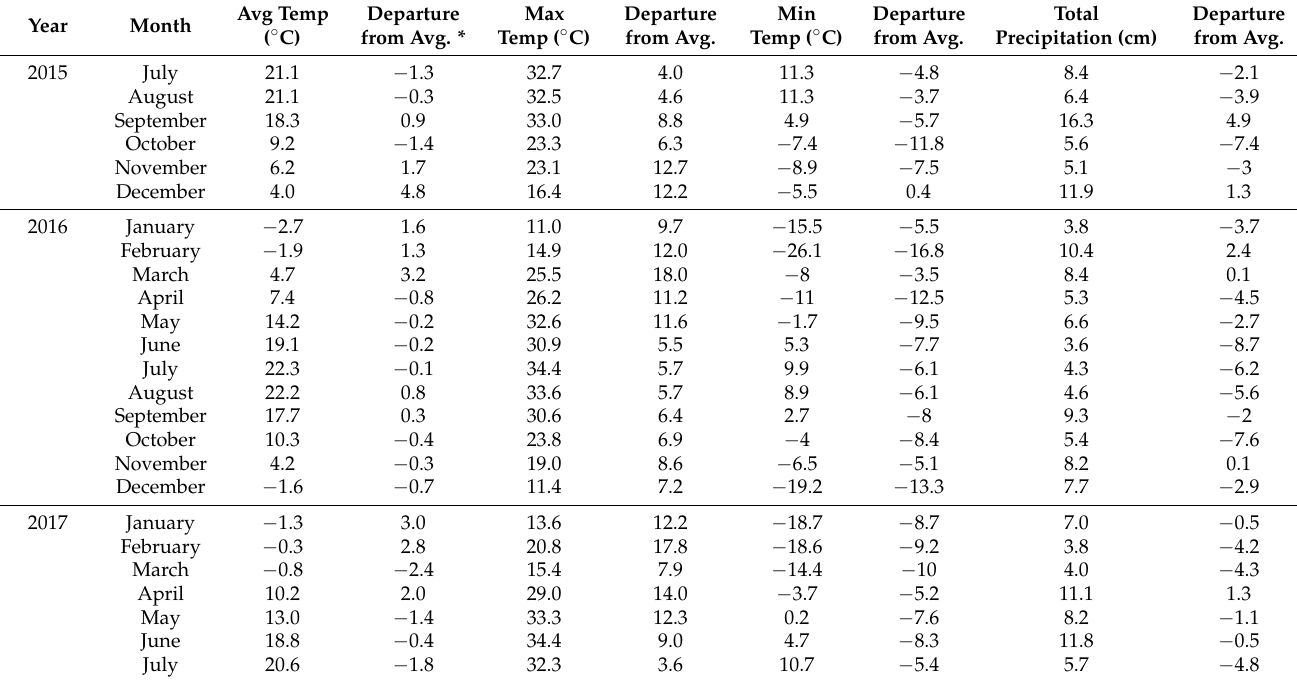
Table 1. Weather Data for the experimental site in 2015 and